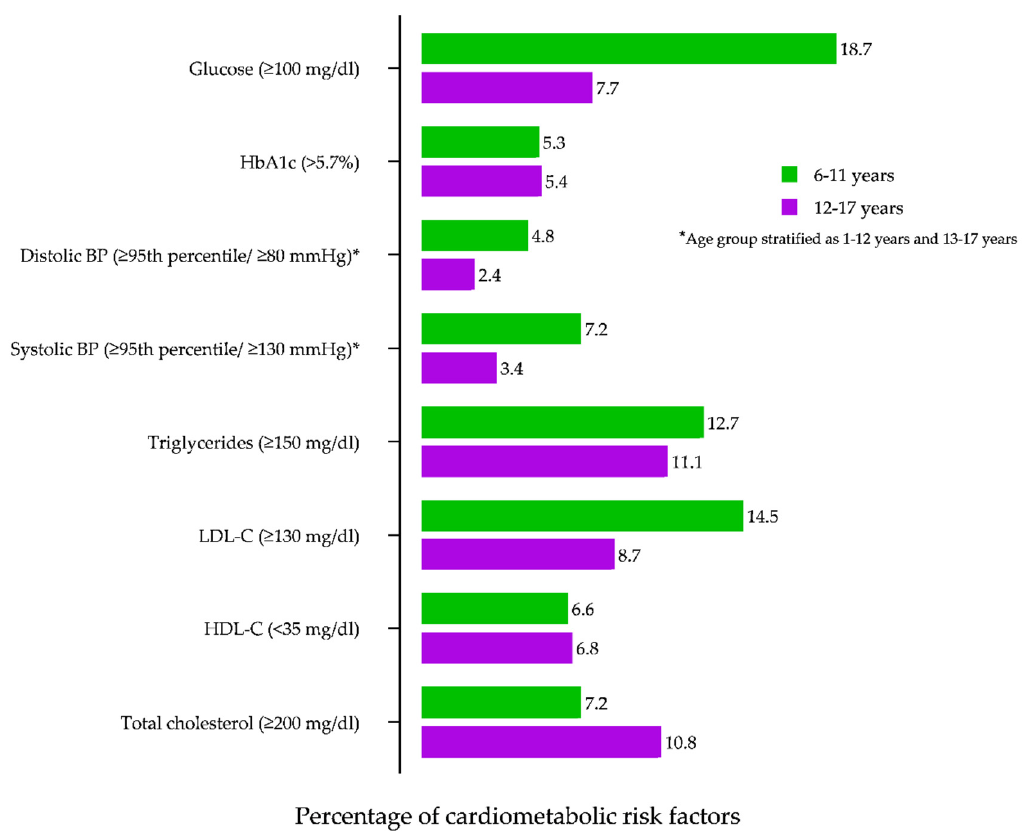
Figure 1. Distribution of cardiometabolic risk factors in children with excess body weight. HDL—high-density lipoprotein; LDL—low-density lipoprotein, BP—blood pressure.